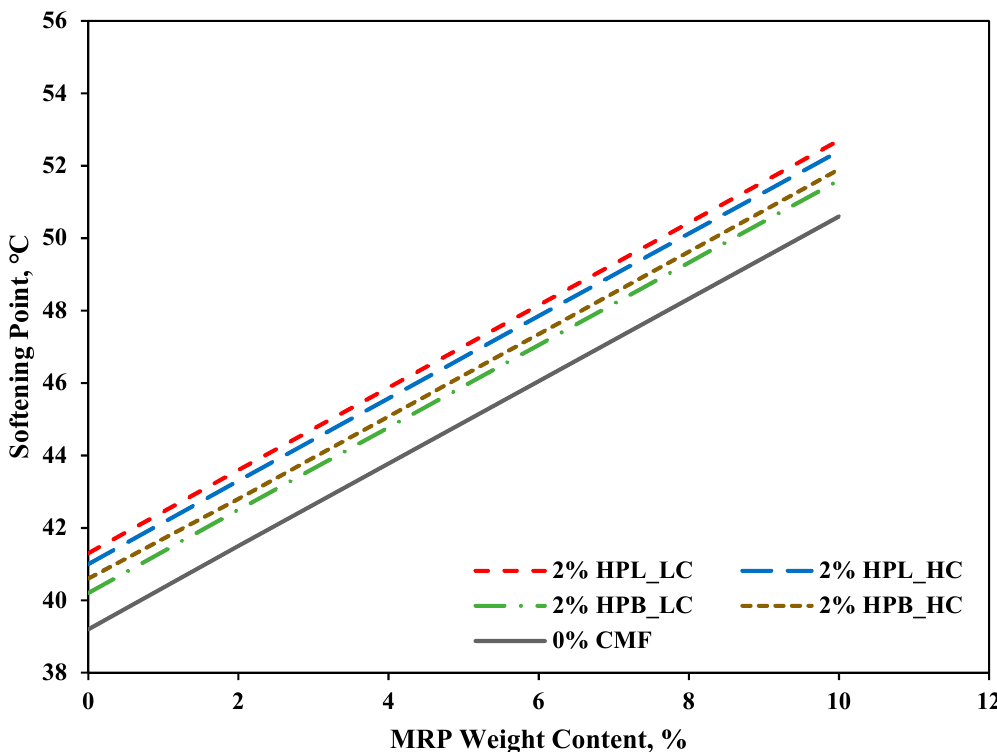
Figure 5. Effect of MRP content and CMF type on softening point at 0% and 2% CMF content.